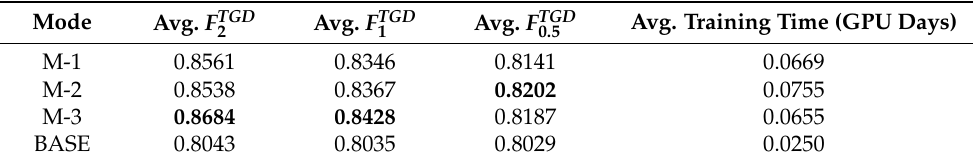
Table 3. Model performance evaluation